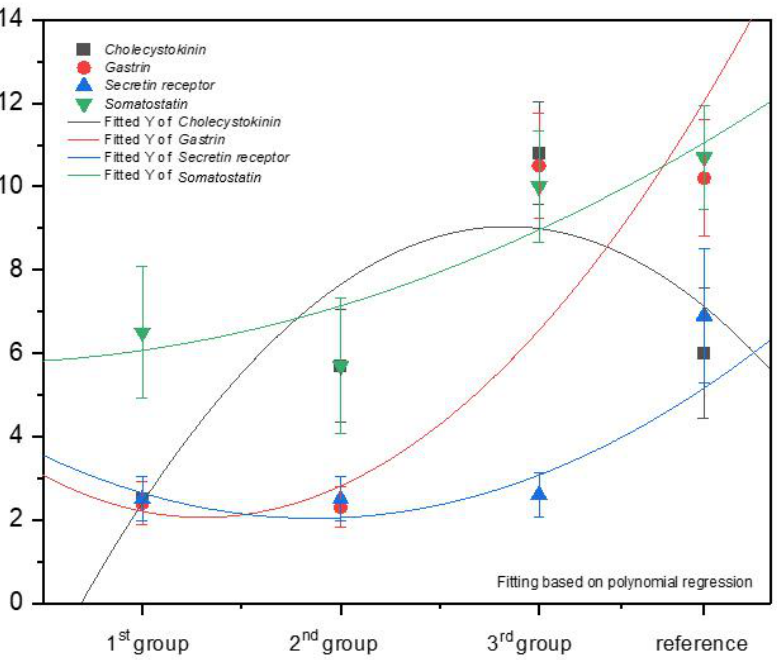
Figure 12. Expression of selected antibodies in the pyloric part of the stomach in the investigated age groups.